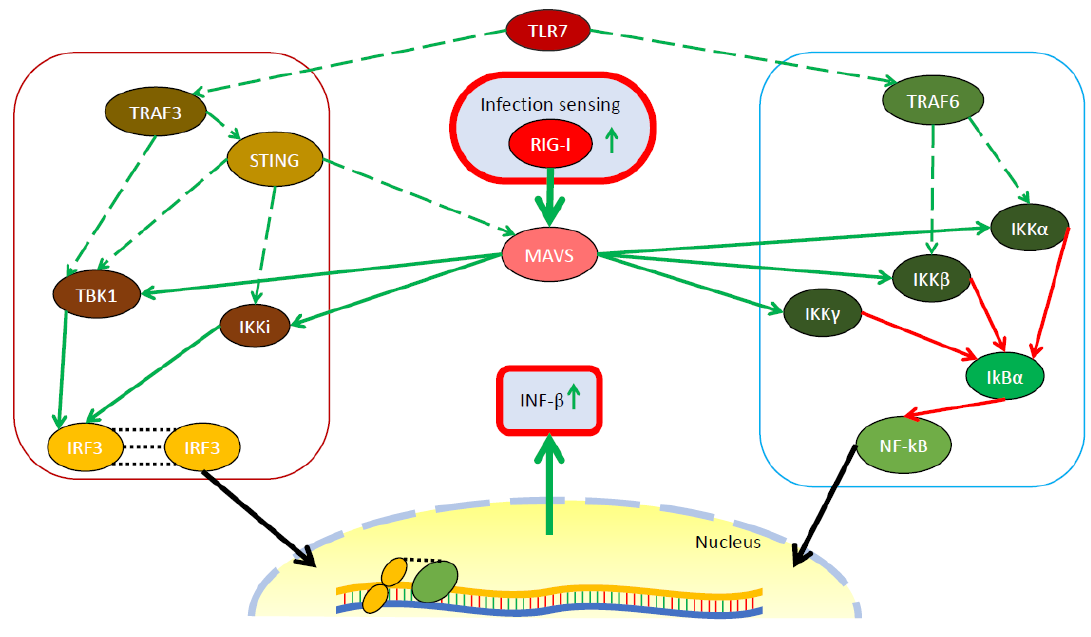
Figure 2. Schematic representation of the e ff ect of SARS-CoV PLP on host cells’ immune system. The two proposed immune pathways a ff ected by the SARS-CoV PLP are schematically represented here. Once the virus is detected by pathogen recognition receptors as RIG-I, the signal is transduced via MAVS to the activating kinases of the transcription factors: IRF3 and NF-kB. TBK1 and IKKi phosphorylate IRF3 and thus trigger its dimerization and nuclear translocation. IKK α - γ free NF-kB, that moves to the nucleus, by phosphorylating its inhibitor, IkB α . Activated STING and TRAF3 form complexes with IRF3 upstream regulators and thus increase the activation state. Finally, IRF3 and NF-kB promote the activation of the type I INF antiviral response. The PLP DUB activity antagonizes these pathways at multiple steps, resulting in a global antagonism of the signaling and lower activation of INF- β . For a detailed description of the interplays between the PLP and the proteins, the reader should refer to the text.